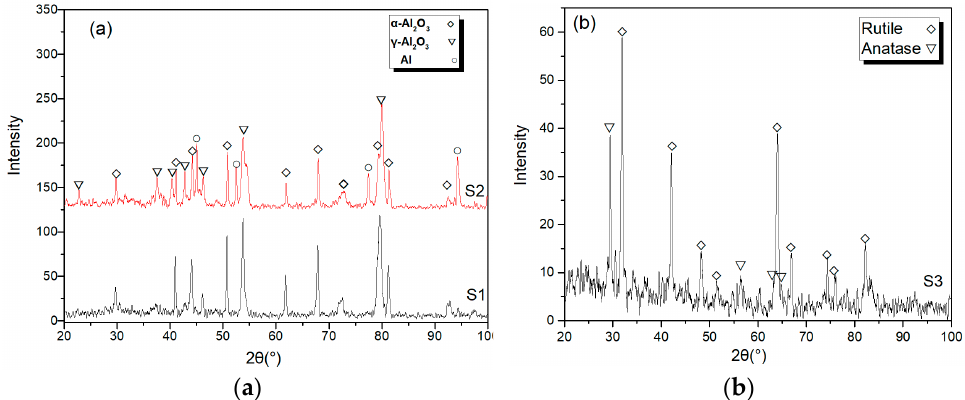
Figure 5. X-ray diffraction patterns of PEO coatings: ( a ) S1, S2; ( b ) S3.